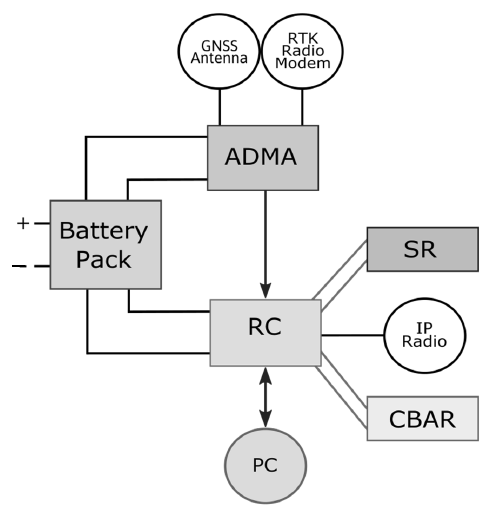
Figure 4. Instrumentation